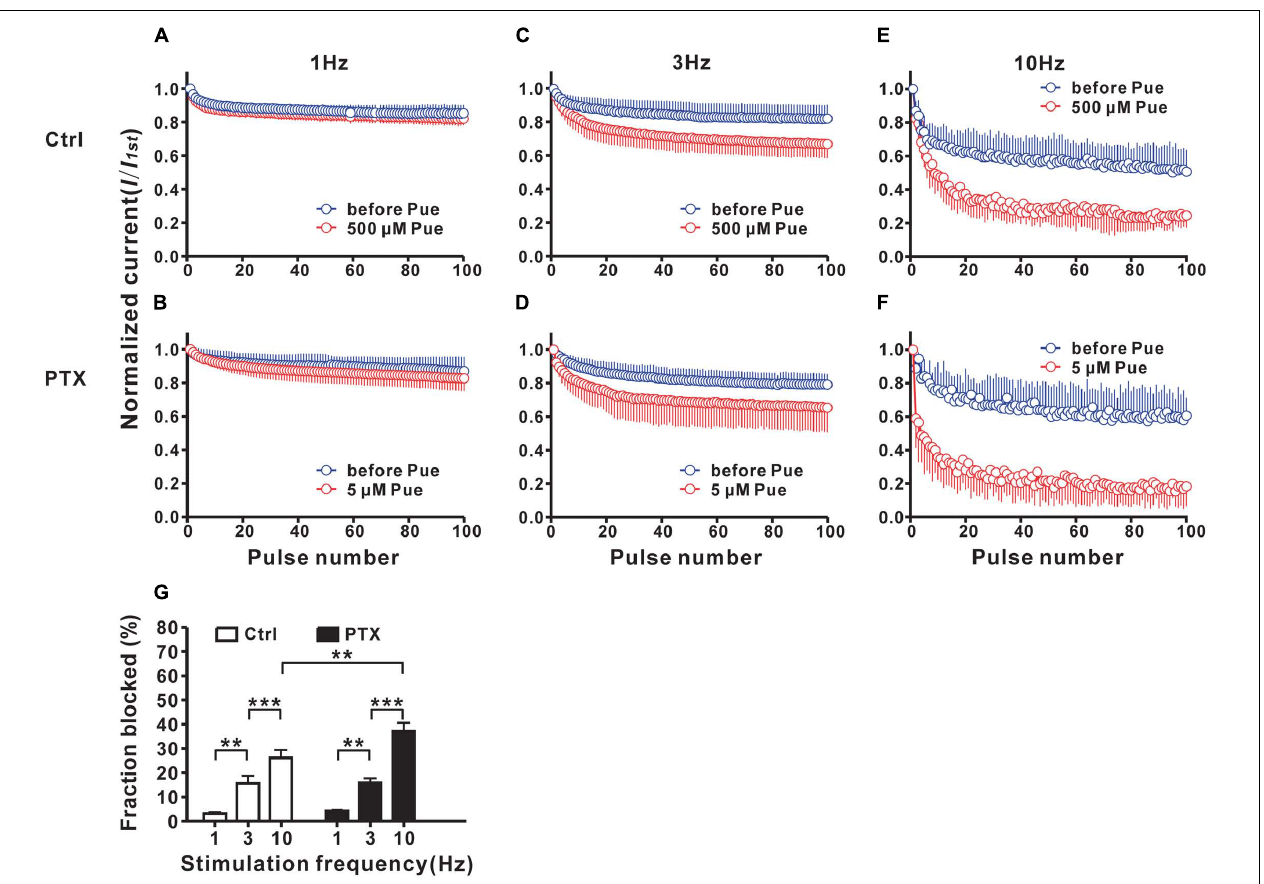
FIGURE 5 | Puerarin use-dependently blocks Na v channels of DRG neurons (Ctrl, control; PTX, paclitaxel; Pue, puerarin). (A–F) The amplitudes of I Na , peak evoked by 100 pulses (from a holding potential of –90 mV to the test pulse of –10 mV, 40 ms) were normalized to those of the first response and plotted against pulse number. The normalized amplitudes at different frequencies in indicated groups were recorded before and 15 min after puerarin application at corresponding IC 50 concentrations. (G) The comparison of the net inhibitory rates calculated with responses elicited by 100 th pulses at indicated frequencies in control and paclitaxel (day 10) groups are shown. n = 9 neurons in each test. ∗∗ P < 0.01, ∗∗∗ P <